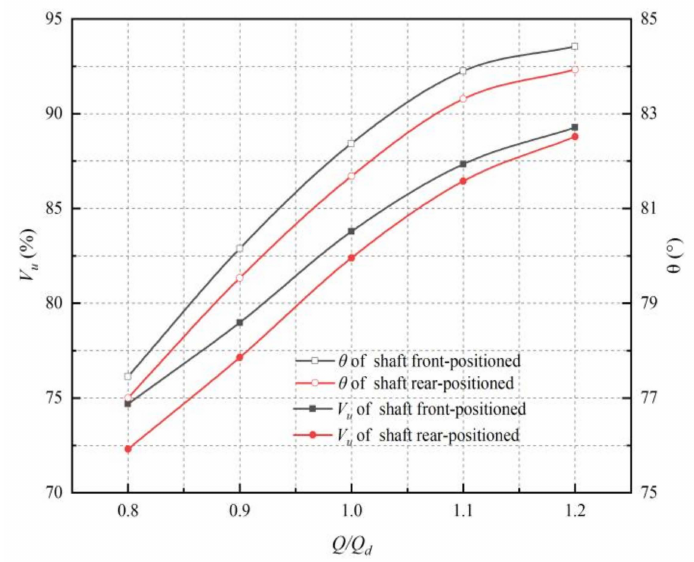
Figure 11. Comparison of V u and θ at the inlet passage